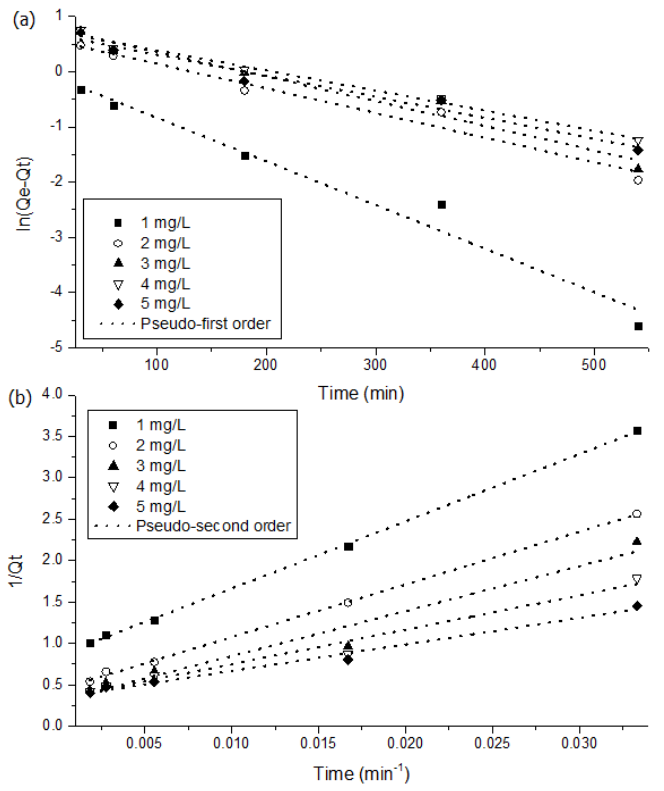
Figure 5. NH 4 -N adsorption capacities of MSSB and PB at different initial NH 4 -N concentrations: ( a ) MSSB, ( b ) PB.